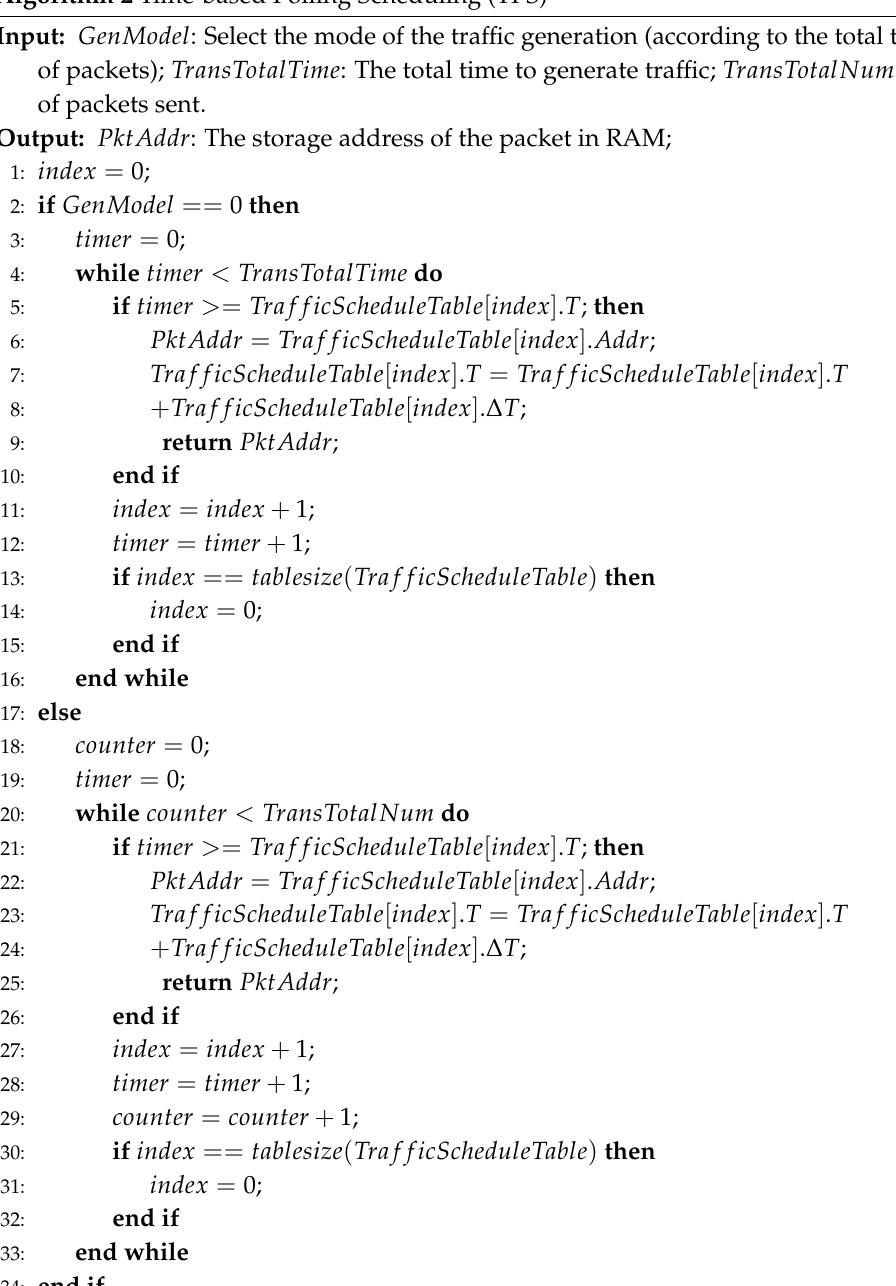
Algorithm 2 Time-based Polling Scheduling